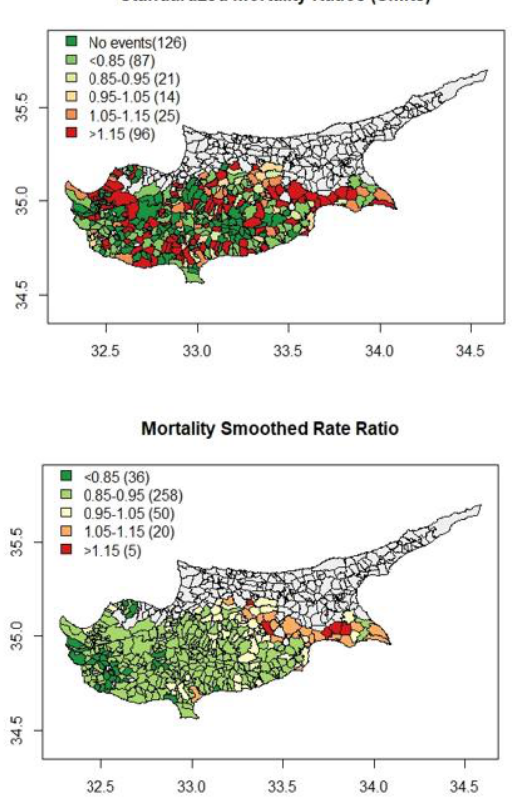
Figure 3. Choropleth maps of the CRC gender and age Standardised Mortality Ratios (SMRs) and smooth CRC gender and age Standardised Mortality Ratios (smooth SMRs).